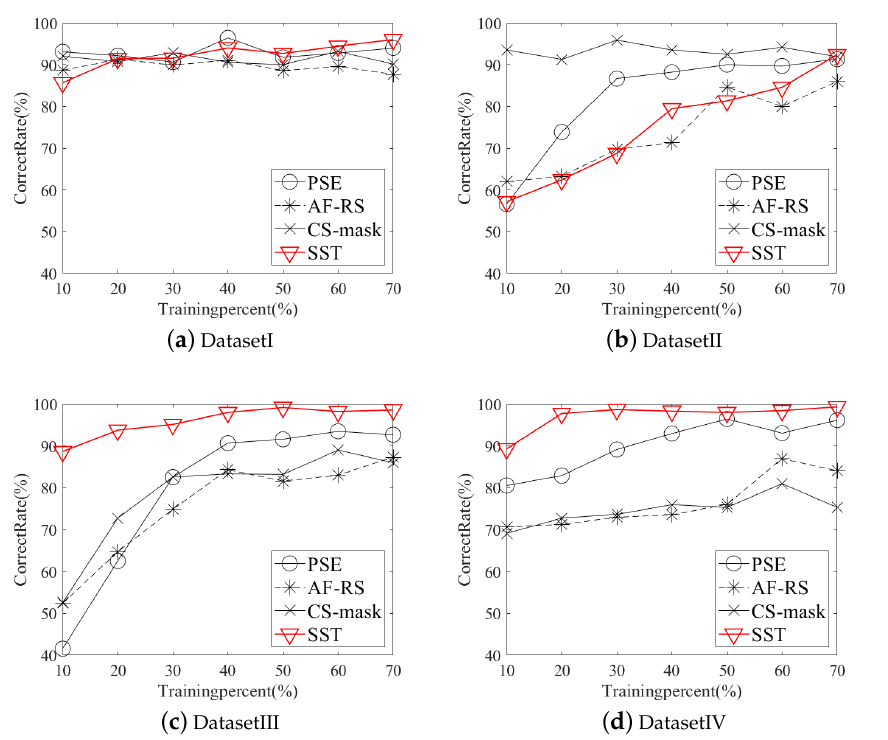
Figure 12. Recognition rate for each Dataset.